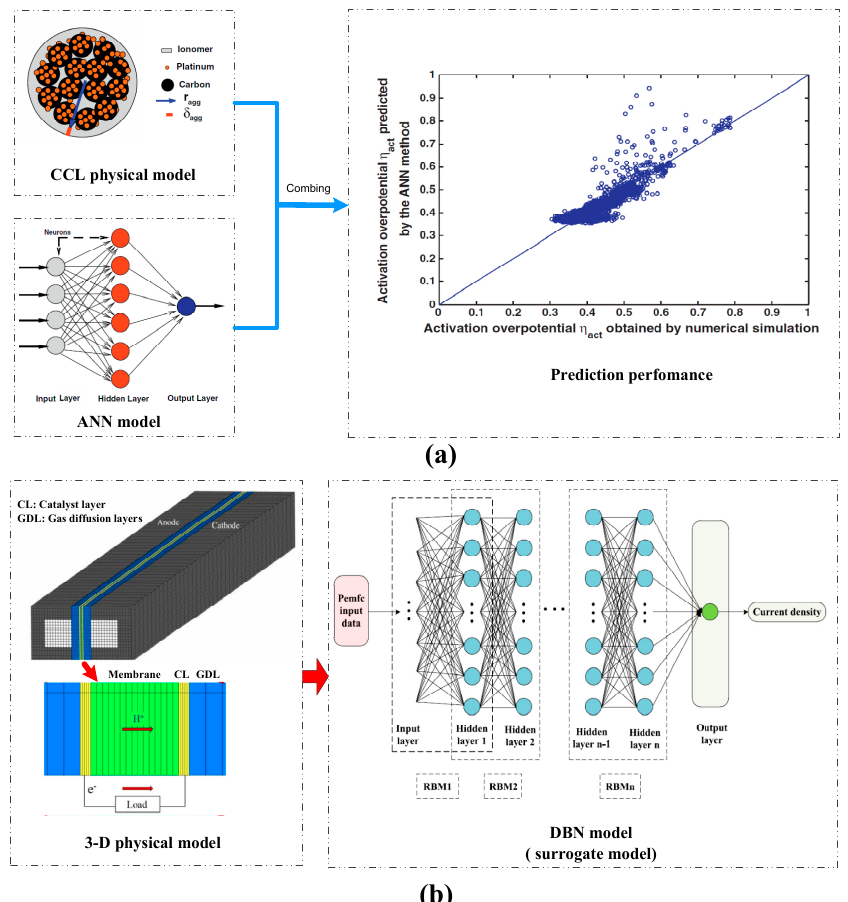
Figure 10. Typical chemical reaction molding based on ML and physical model; ( a ) prediction of the CCL performance based on the combination of CCL physical and ANN models [56]; ( b ) an intelligent method, integrating a 3D physical model and a DBN model, to predict the current density of a PEMFC [58].